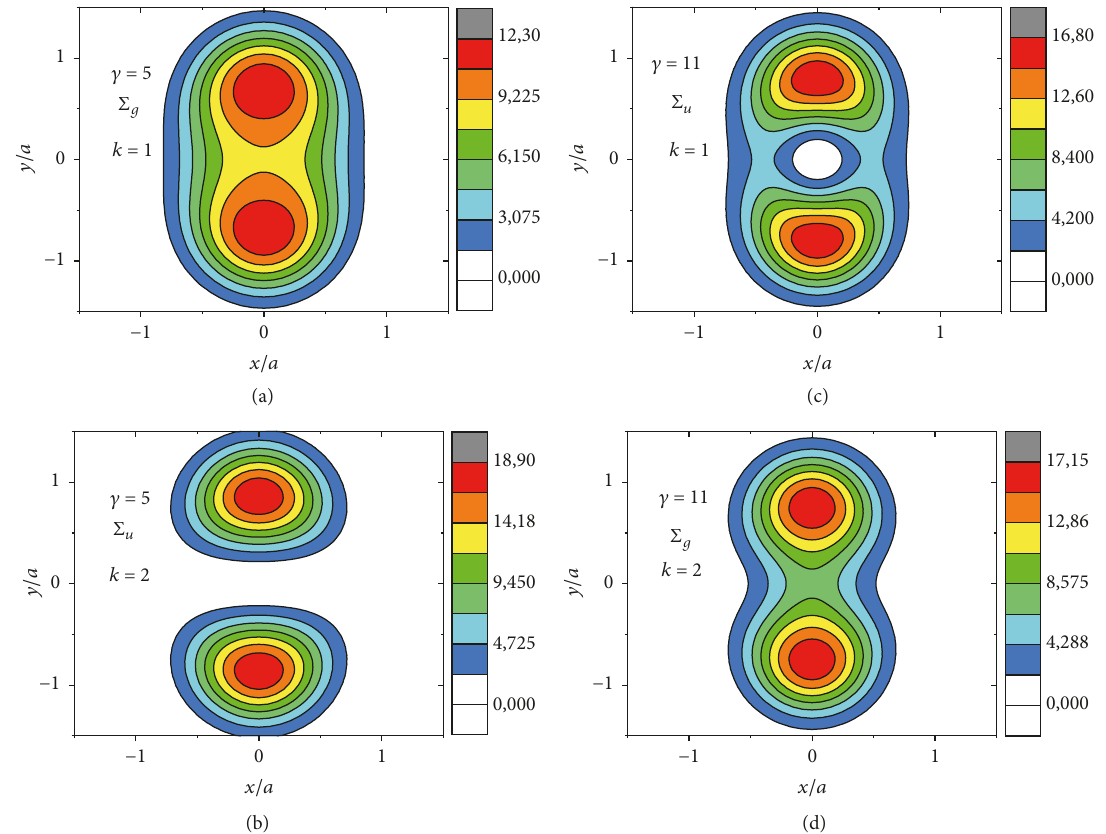
Figure 8: Charge distribution for on-center donor in the ground (𝑘 = 1) and in the first excited (𝑘 = 2) states for the magnetic field strengths 𝛾 = 5 and 𝛾 = 11 in elongated QR with the eccentricity parameter 𝑒 = 1 .